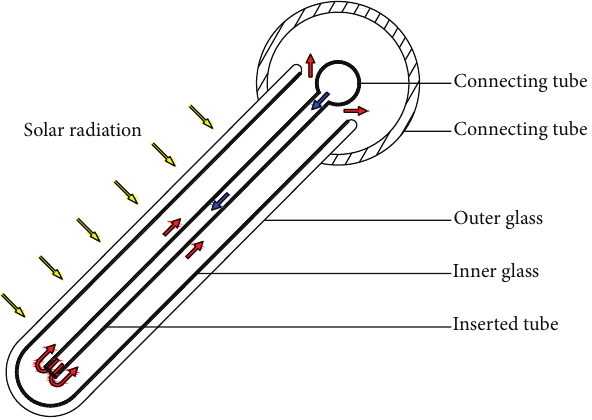
Figure 9: The heat transfer mechanism of novel collector.